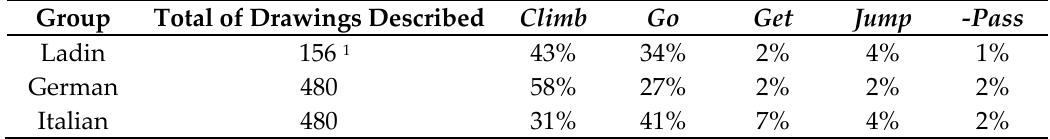
Table 9. The most frequent verbs in the description of the twelve drawings in the learner groups.